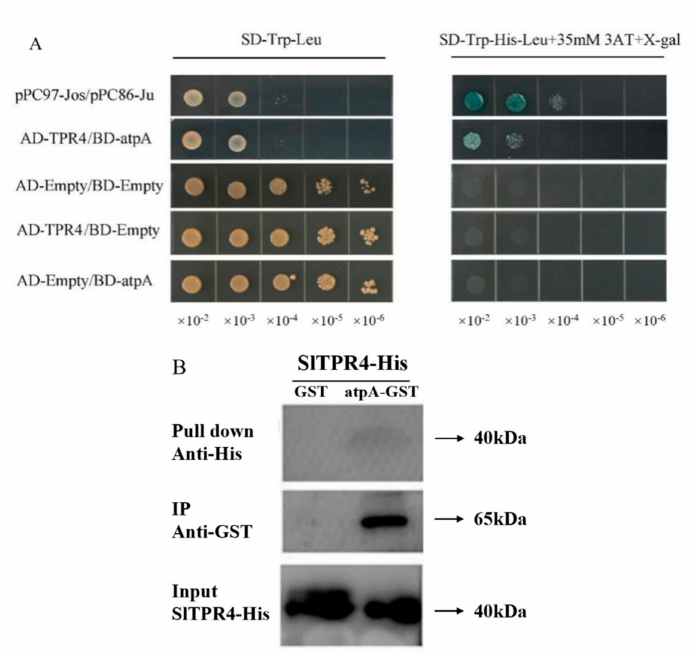
Figure 8. Identification of SlTPR4 and atpA protein interaction. ( A ) Yeast cells co-transformed with different constructs were grown on selective media lacking Leu and Trp for 3 days to express TPR4 and atpA. Then the colonies were transferred to lacking Leu, Trp and His selection medium containing 35 mM 3-Aminotriazole (3AT) and cultured for three days to observe their growth. X-gal was added to the yeast grown in the three-deficiency medium and observe the blueness. pPC97- Jos/pPC86-Jun was used as a universal positive control. ( B ) Purified GST-atpA and GST proteins were incubated with TPR4-His, which were immobilized with Glutathione Sepharose 4B beads. The proteins were immunoprecipitated with anti-GST antibody and pulled down with anti-His antibody. The GST protein was included as a negative control. Three independent experiments were performed with similar